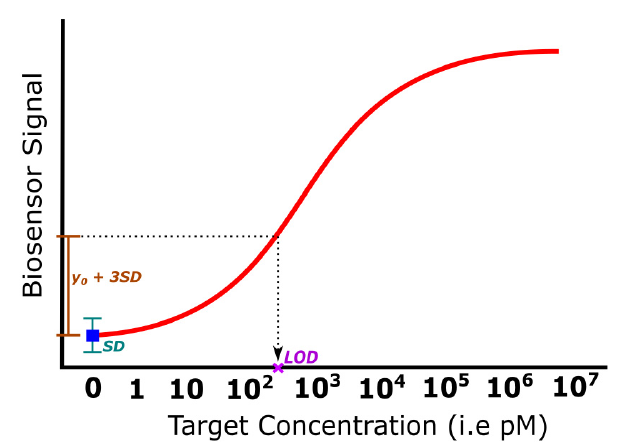
Figure 8. The basic concept for determination of the LOD in a fitting curve of the biosensor response.